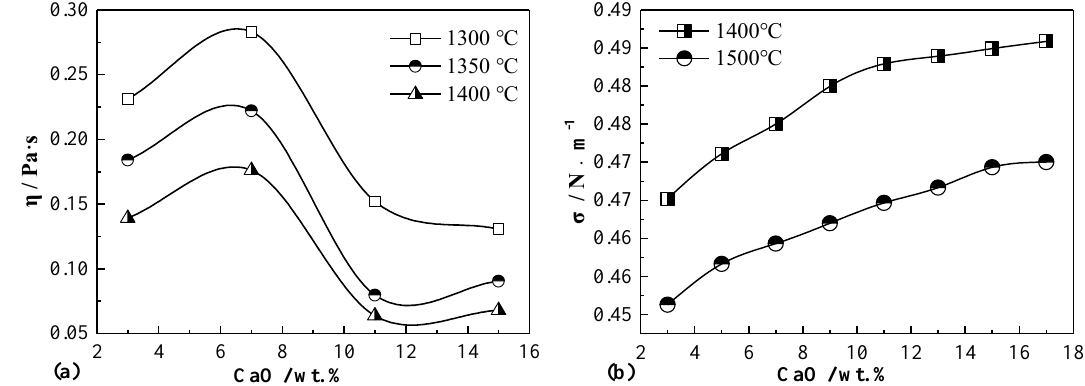
Figure 10. E ff ect of CaO on the Fe x O-SiO 2 -CaO-MgO-“NiO” slag ( a ) viscosity; ( b ) surface tension.